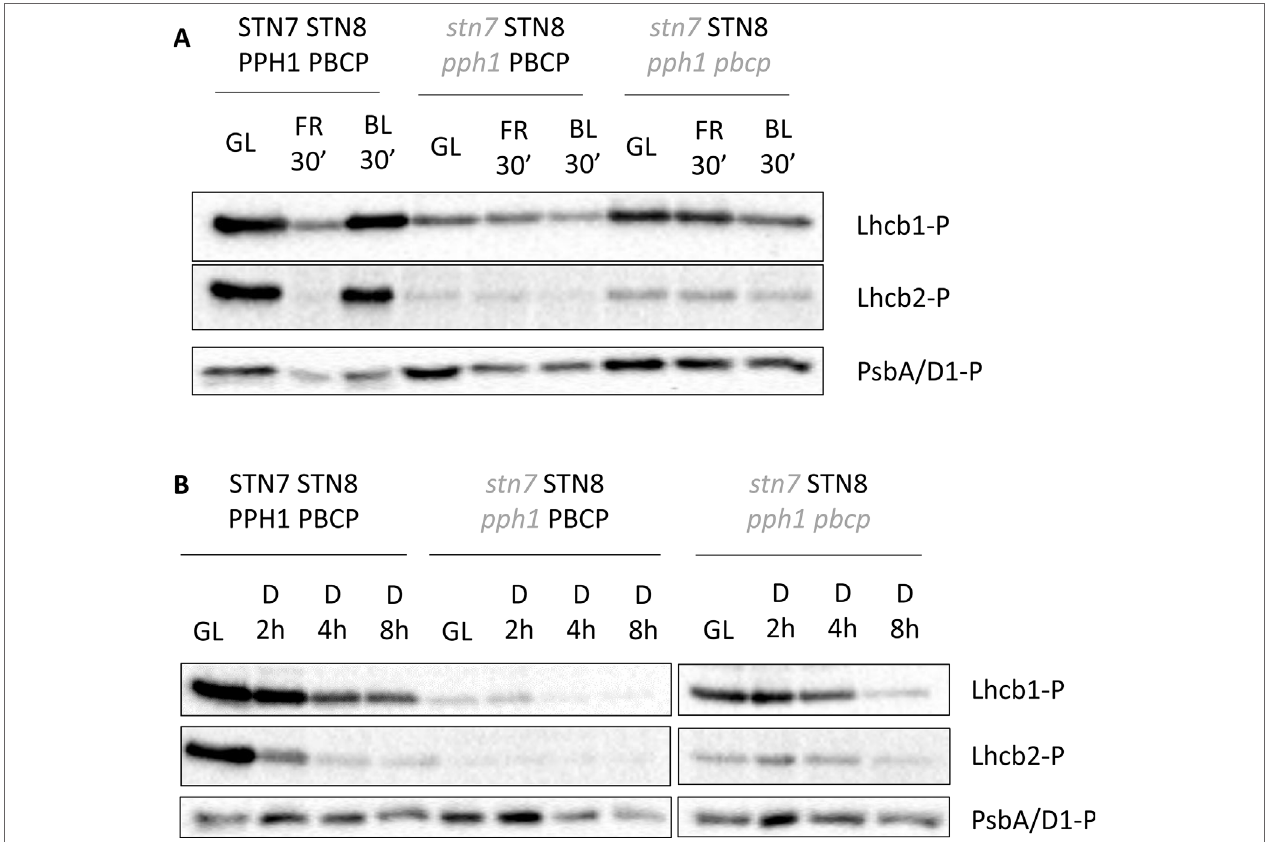
FIGURE 2 | Lhcb1 and Lhcb2 phosphorylation dynamics after changes in light quality or prolonged darkness. (A) Total protein extracts from Arabidopsis thaliana mature leaves collected under white light (GL 100 µmol photons m −2 s −1 ), then exposed for 30 min to far red light (740 nm) and subsequently exposed to blue light (450 nm, 60 µmol photons m −2 s −1 ). (B) Total protein extracts from Arabidopsis thaliana mature leaves collected under white light (GL 100 µmol photons m −2 s −1 ) or after increasing time in total darkness (2, 4, and 8 h). The extracts were tested with antibodies recognizing the phosphorylated form of Lhcb1 (Lhcb1-P), Lhcb2 (Lhcb2-P) or PsbA/D1